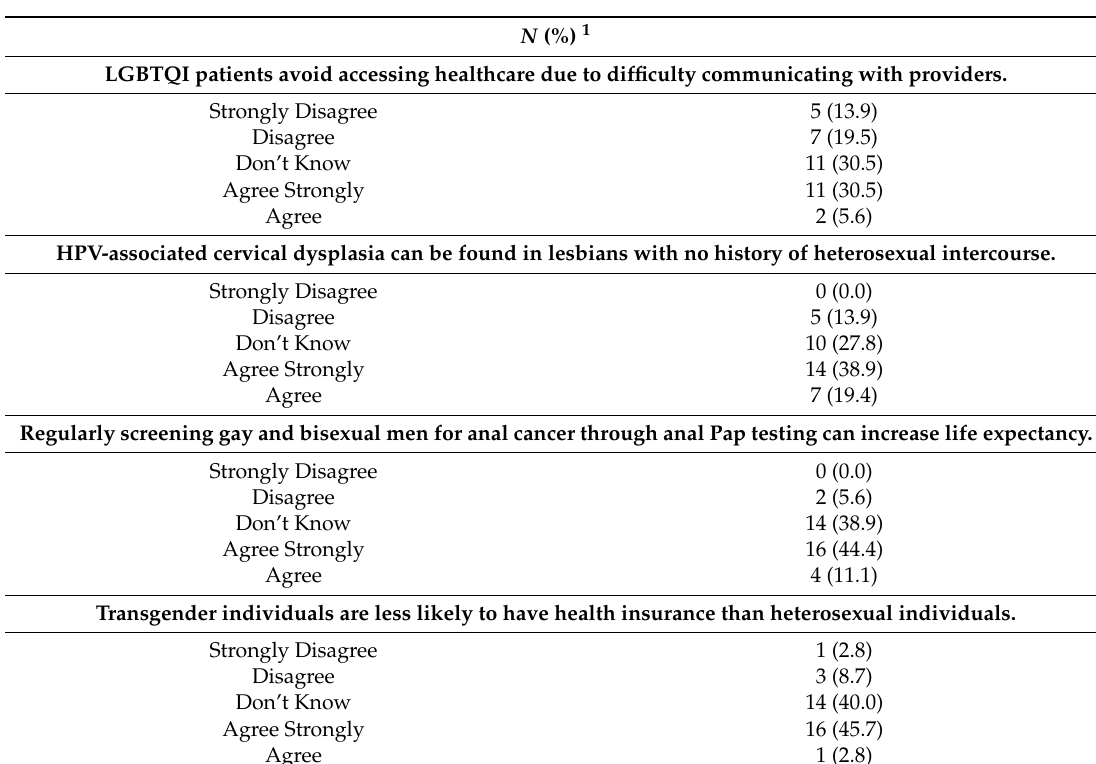
Table 2. Knowledge of LGBTQ health among indicated providers ( N =